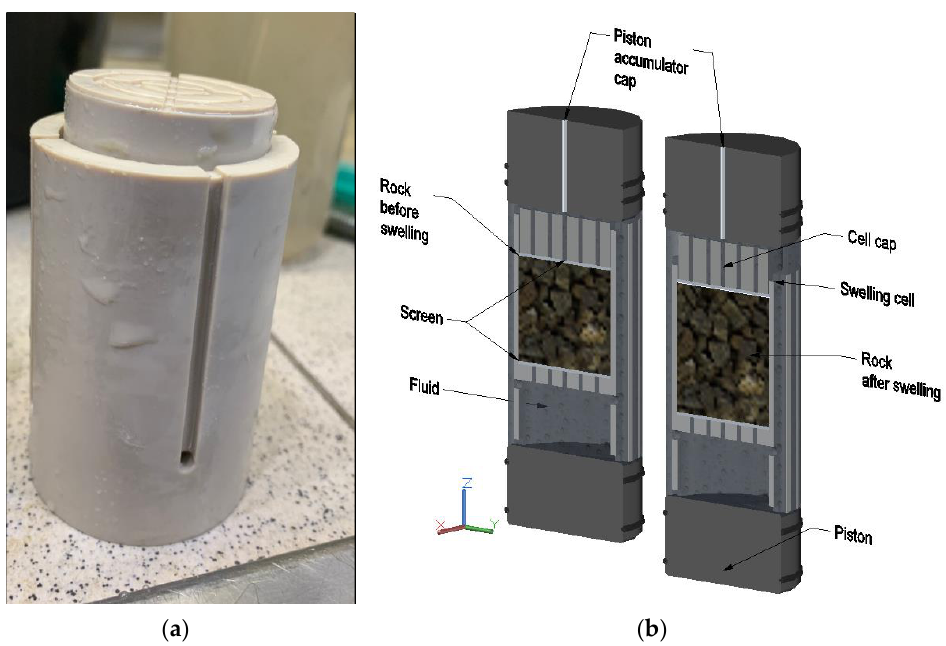
Figure 2. Rock swelling cell: ( a ) Photo, ( b ) 3D image and working principle. The rock swelling was quantified using a volumetric expansion coefficient α (%